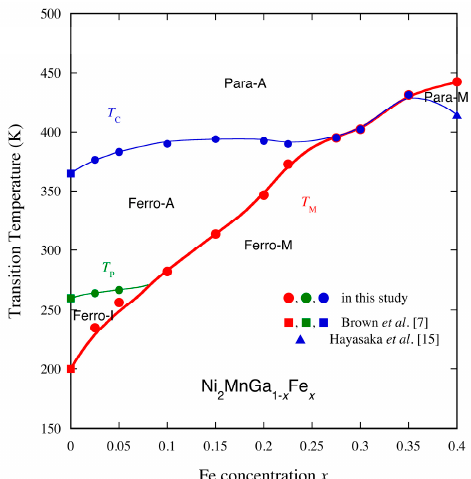
Figure 3. Phase diagram for Ni 2 MnGa 1– x Fe x (0 ≤ x ≤ 0.40). Para-A and Para-M represent the paramagnetic austenite phase and the paramagnetic martensite phase, respectively. Ferro-A and Ferro-M represent the ferromagnetic austenite phase and the ferromagnetic martensite phase, respectively. Ferro-I means the ferromagnetic premartensite (intermediate) phase.